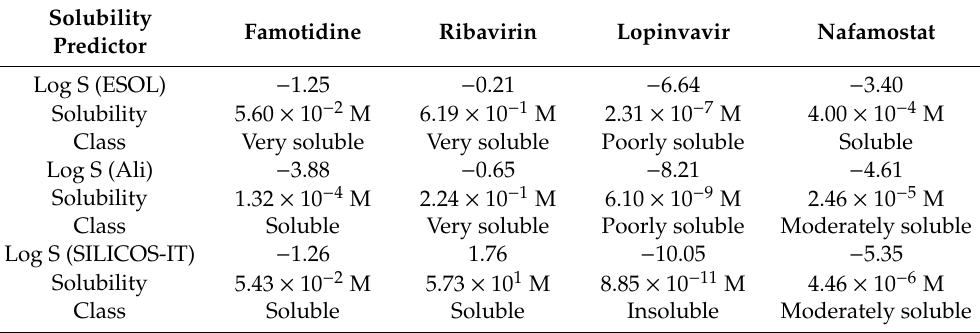
Figure 6. The analysis of pharmacokinetic parameters of protease inhibitors. Chemical structures and administration, distribution, metabolism, and elimination (ADME) parameters for famotidine, ribavirin, lopinavir, and nafamostat, drugs that were evaluated as SARS-CoV2 inhibitors, are shown. The colored zone is a suitable physicochemical space for oral bioavailability obtained using the SWISSADME software. The compounds were scored based on the structure and whether these parameters fit into the values established for each indicator related to oral bioavailability. LIPO (lipophility), SIZE (size), POLAR (polarity), INSOLU (insolubility), INSATU (instauration), and FLEX (flexibility). The 2D structures of each drug are shown with the specific atoms represented as follows: carbon in gray, oxygen in red, nitrogen in blue, and sulfur in yellow. Table 6. Water solubility of drugs used as inhibitors of SARS-CoV2